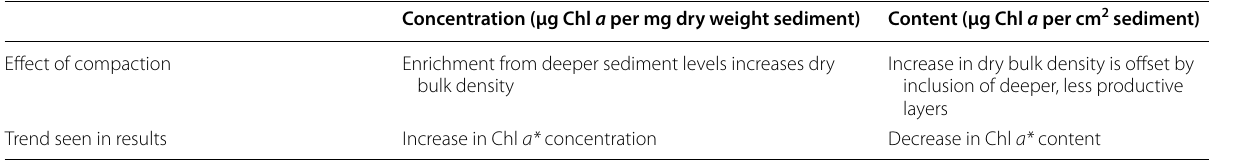
*Chl a refers to chlorophyll a , a proxy for algal biomass that can be expressed as either a concentration or a